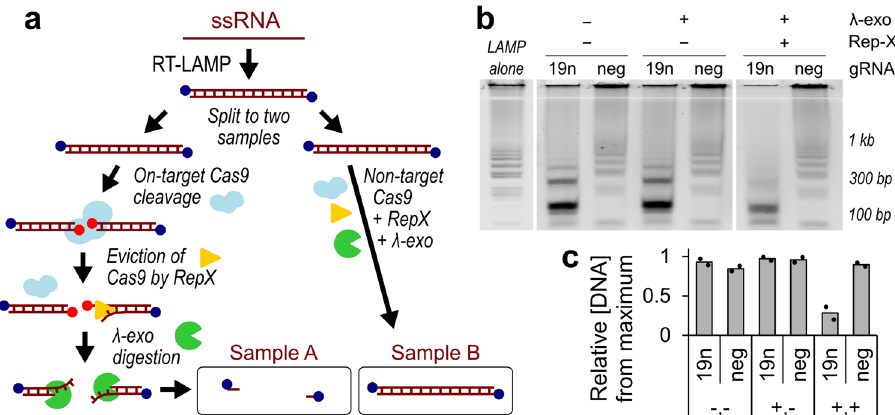
Fig. 1 Schematic and characterization of endonuclease actuated nucleic acid detection. a Schematic of SENTINEL mechanism of action. Blue circles at the 5 ′ ends of the RT-LAMP product represent 5 ′ phosphorothiolate modi fi cations. Red circles at the 5 ′ ends represent 5 ′ phosphates exposed from endonuclease action. b Agarose gel electrophoresis of (lane 1) SARS-CoV-2 N-gene RT-LAMP product alone, or with additional (lane 2, 3) Cas9 cleavage using on-target (19n) and non-target (neg) gRNA, (lane 4, 5) digestion with λ -exo, and (lane 6, 7) unwinding with RepX superhelicase. The RT-LAMP product (lane 1) is not altered with exposure to λ -exo (lane 5 —‘ neg ’ ), suggesting that 5 ′ phosphorothiolate effectively prevents λ -exo end-degradation. Lane 1 – 7 is oriented from left to right. Lane 2 – 3: On-target gRNA led to downward shift in gel bands, consistent with cleavage of RT-LAMP product. Lane 4 – 5: Addition of λ -exo did not lead to appreciable change in cleaved RT-LAMP product. Lane 6 – 7: Addition of λ -exo with Rep-X led to appreciable degradation of RT-LAMP product, only for the sample with on-target gRNA. In contrast, the sample with off-target gRNA was consistent across panel ( b ). c Quanti fi cation of panel b lanes 2 – 7 across two biological replicates (black dots), by measuring average fractional intensities of each lane on the agarose gel relative to the maximum intensity across all lanes. Lanes 2 – 7 in panel b correspond to lanes 1 – 6 in this panel, both oriented from left to right.